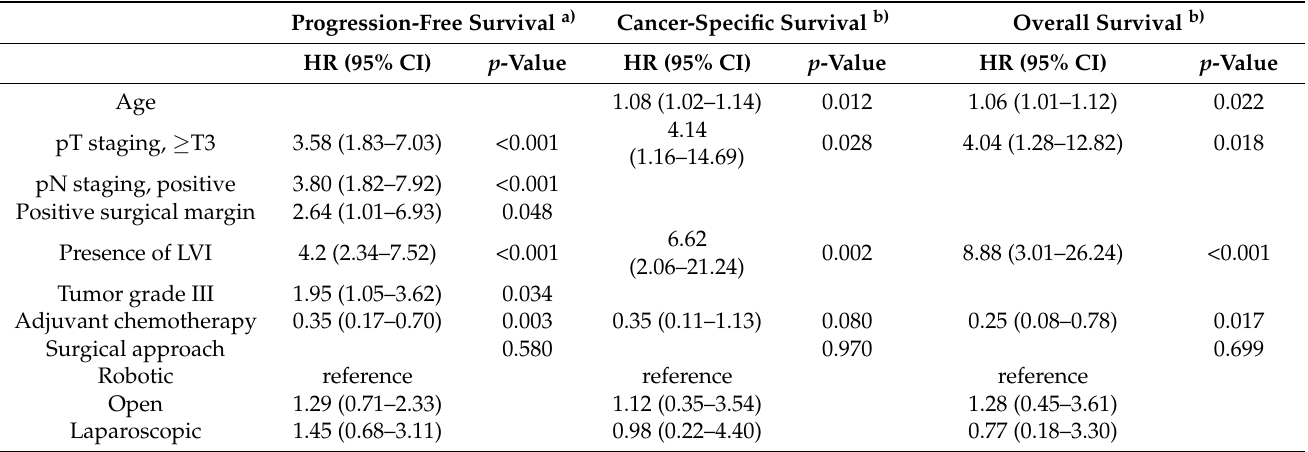
Table 3. Multivariate analysis with Cox-proportional hazards regression to predict progression-free survival, cancer-specific survival, and overall